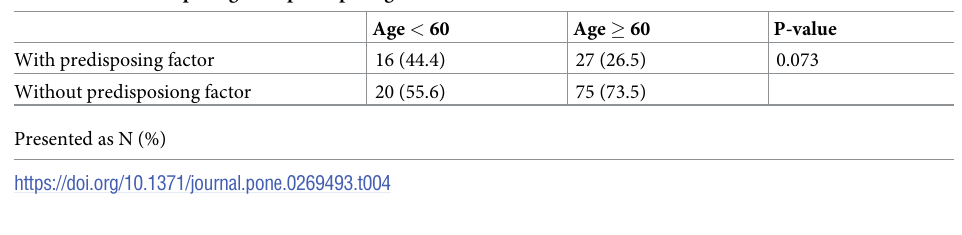
Table 4. Relationship of age and predisposing